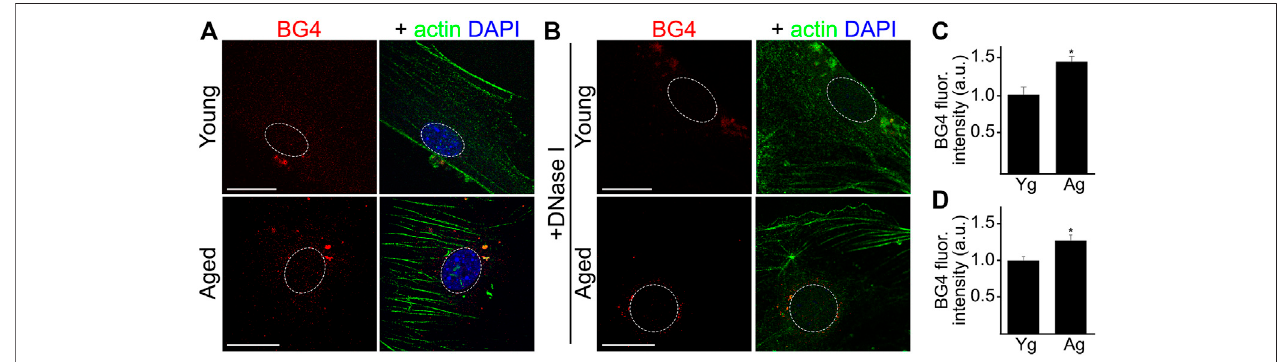
FIGURE2| CulturedCECfromagedmice showedhigher levelsofRNA-G4than cultured youngCEC. (A) CEC wereisolatedfromyoung(4-m/o) andaged(20-m/ o) female mice and cultured. Cells were fi xed and stained with antibodies against G4 (BG4) anti against actin, and with the nuclear Hoechst dye. (B) Cultured CEC from young and aged female mice were fi xed and incubated with DNaseI toeliminate DNA G4, and then stained with antibodies against G4 (BG4) and against actin, and with the nuclear Hoechst dye. (C , D) BG4 fl uorescence intensities were measured. (C) Quanti fi cation from (A) . Scale bar (Yg), 20 μ m; Scale bar (Ag), 40 μ m. t -test, * p -value (cid:2) 0.0116. (D) Quanti fi cation from (B) . t -test, * p -value (cid:2) 0.0435. Data were pooled from three independent experiments analyzing 50 cells per condition and experiment.